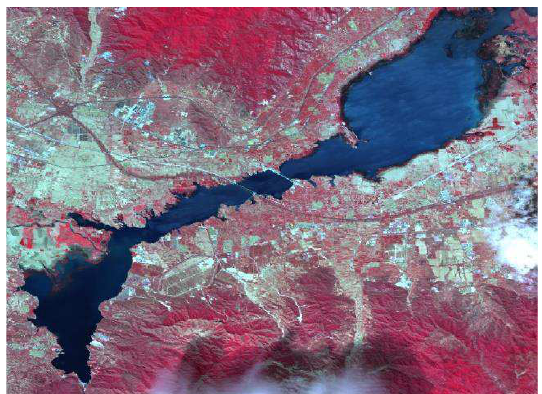
Figure 2. False-color composite of the AHSI surface reflectance image of Guanting